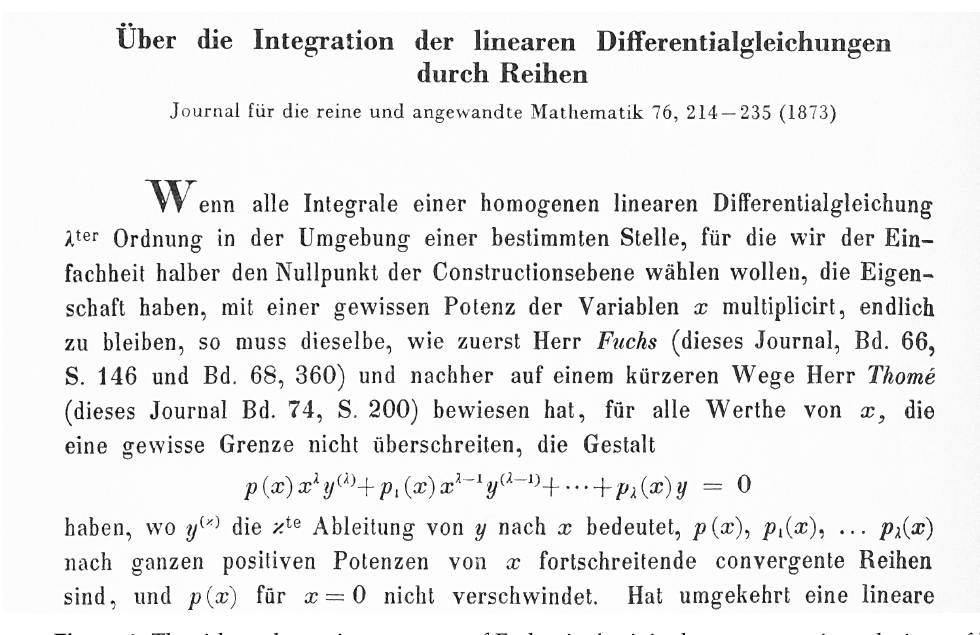
Figure 1. The title and opening sentence of Frobenius’ original paper on series solutions of linear differential equations [6]. Note that, as in the works of Fuchs [11,12], differential equations of n-th order were addressed, in full generality. To avoid prolixity and to allow focus instead, in our manuscript here, we restrict our coverage to second order equations. Frobenius introduced the name P ( y ) for the left hand side of the equation shown here. This corresponds to our linear operator L , i.e., to our expression